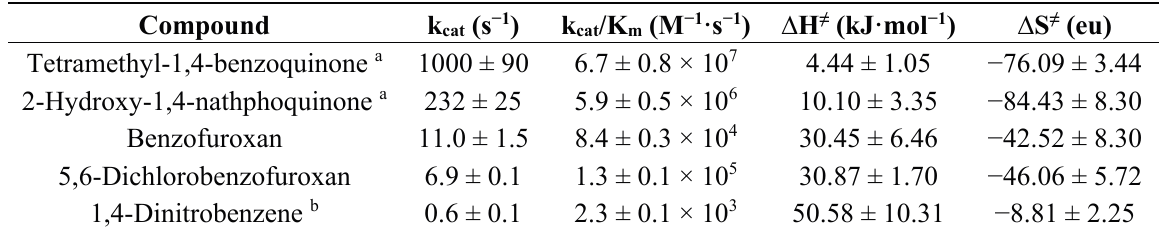
Table 5. The k cat and k cat /K m values of NQO1-catalyzed reduction benzo- and naphthoquinones, BFXs and 1,4-dinitrbenzene, and their activation enthalpies ( ∆ H ≠ ) and entropies ( ∆ S ≠